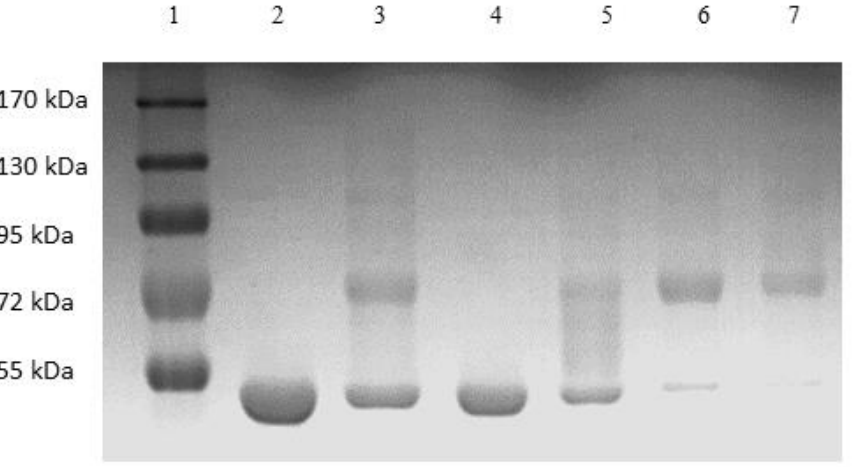
Figure 6. Image of Coomassie-blue-stained SDS-PAGE gel of sample obtained by stirred cell hybrid separation (lane 1: MW markers, lane 2 HSA, lane 3 PEG reaction mixture, lane 4 sample 1 (1.65 M flow-through), lane 5 sample 2 (1.5 M eluate), lane 6 sample 3 (1.35 M eluate), lane 7 sample 4 (0 M eluate)).